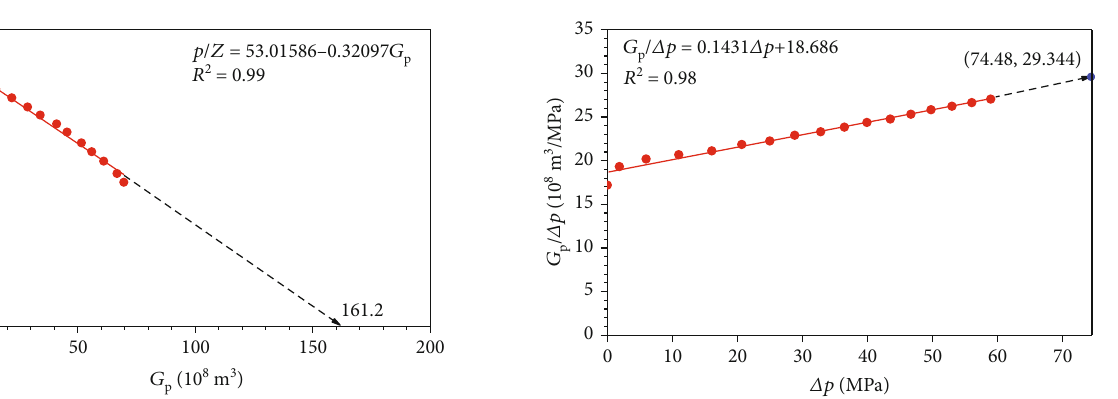
Figure 8: Reserves of X gas reservoir calculated by the method of gas production of cumulative unit pressure drop.